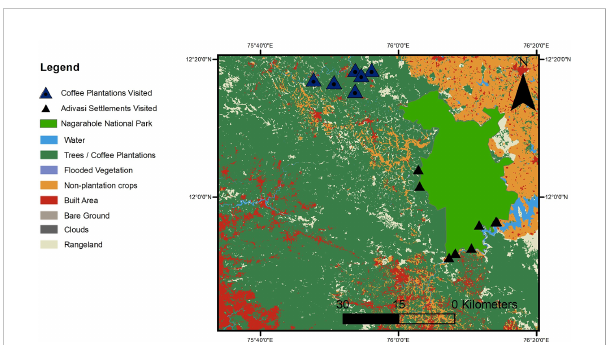
FIGURE 2 Location of Coffee Plantations and Adivasi settlements visited during the study. (Kontgis et al., 2021). Avalable at: https://www.arcgis.com/ home/item.html?id=196281a3ee5b4296ad594d34db56e543. Nagarahole National Park Layer Credit: Open Street Map information and of fi cial ENVIS listings. Available at: